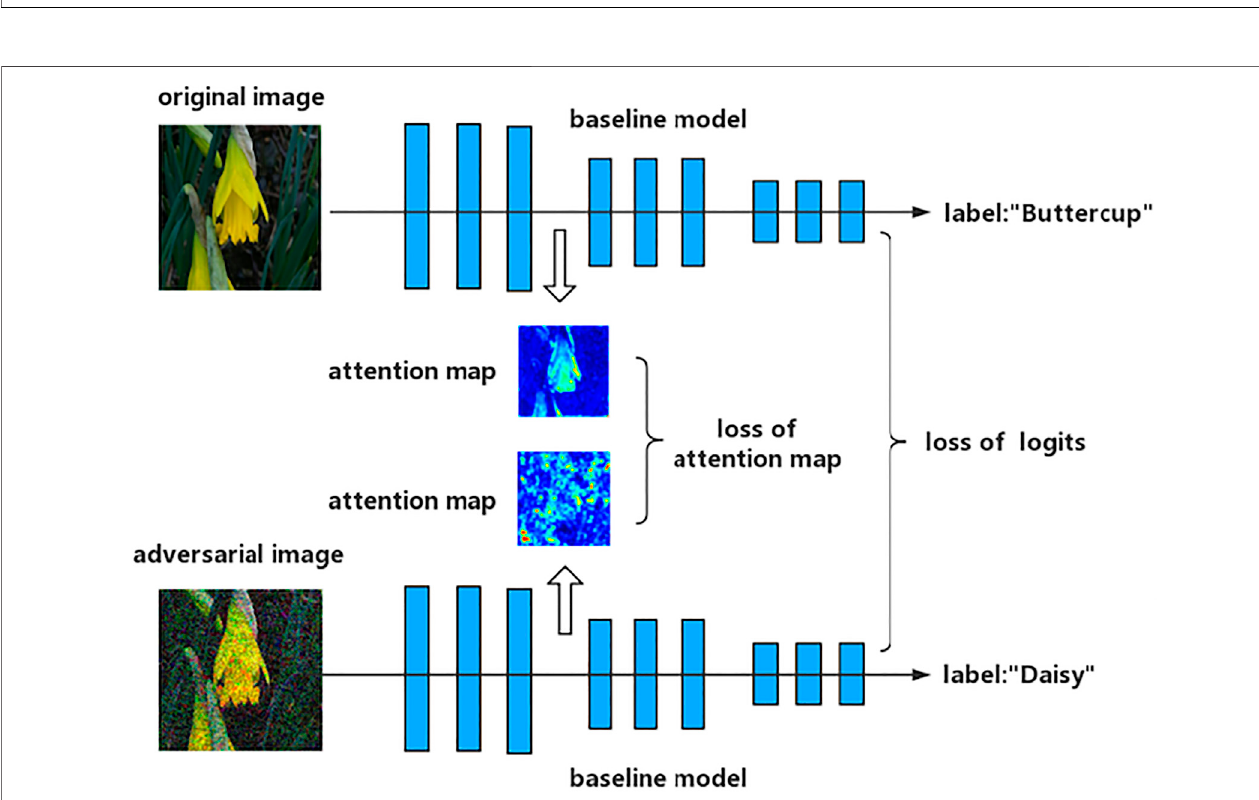
FIGURE 2 | Schematic representation of Attention and Adversarial Logit Pairing (AT + ALP) : a baseline model is trained so as, not only to make similar logits, but to also have similar spatial attention maps to those of original image and adversarial image.